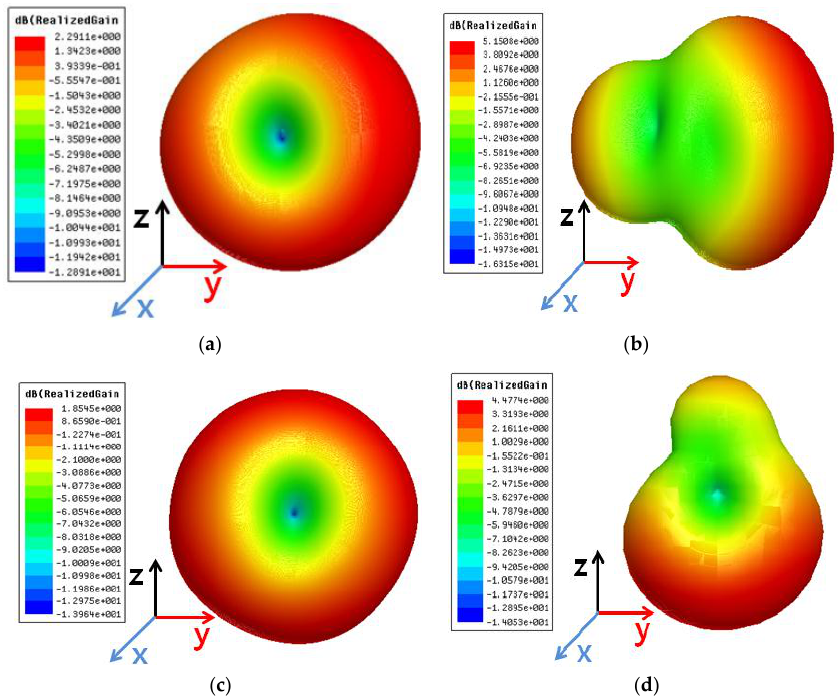
Figure 3. Simulated 3D radiation patterns when ( a ) first antenna is on without reflector, ( b ) first antenna is on with reflector, ( c ) second antenna is on without reflector and ( d ) second antenna is on